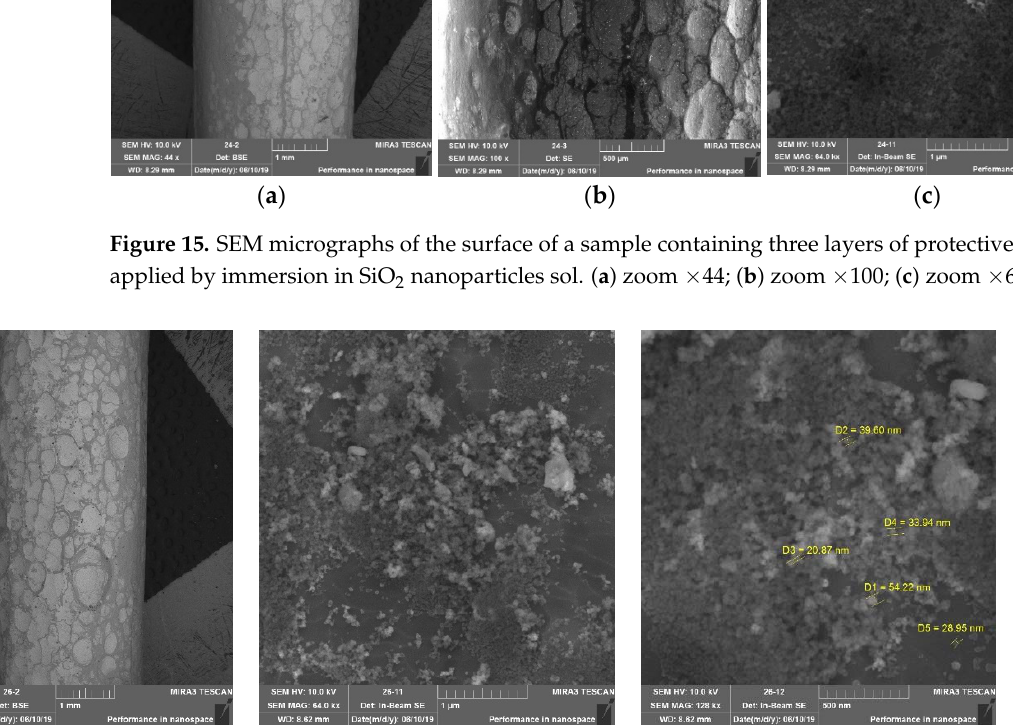
Figure 16. SEM micrographs of the surface of a sample containing five layers of protective coating applied by immersion in SiO 2 nanoparticles sol. ( a ) zoom ×42; ( b ) zoom ×64,000; ( c ) zoom ×128,000.